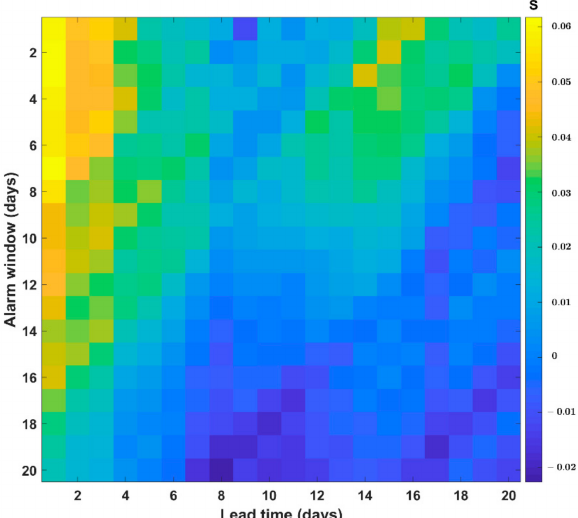
Figure 10. Area skill scores for predictions with di ff erent lead times and alarm windows based on observations. We performed a forecasting experiment and predicted earthquakes with depths of less than 100 km and magnitude ≥ 5.0 during the studied period in and around Taiwan.